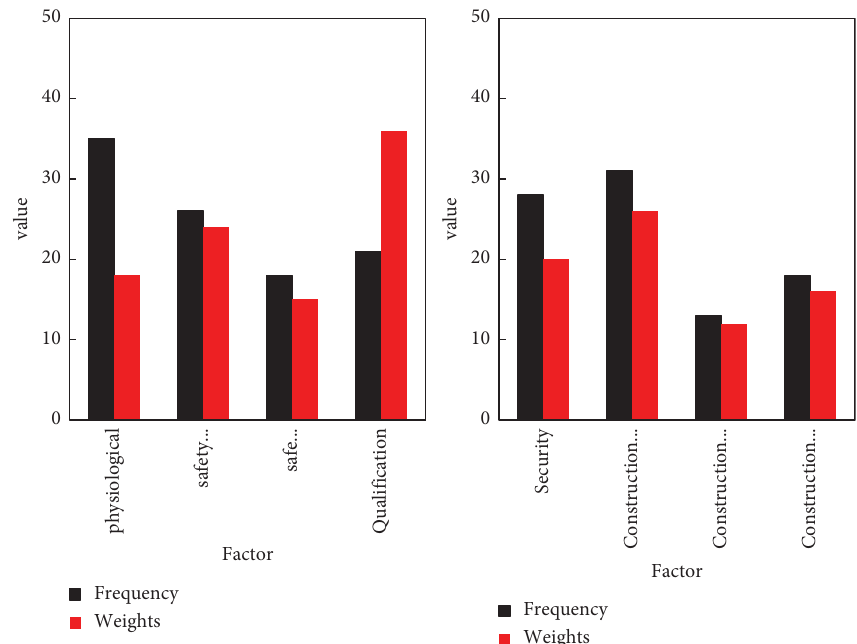
Figure 7: Frequency statistics of human and machine factors.